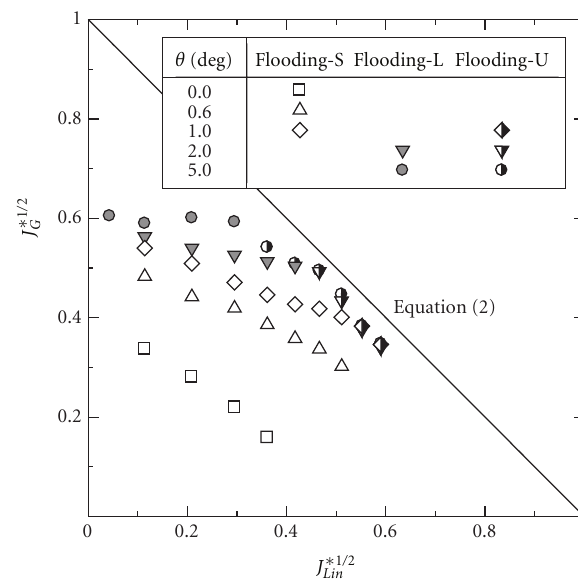
Figure 9: CCFL-L characteristics (e ff ects of θ ).